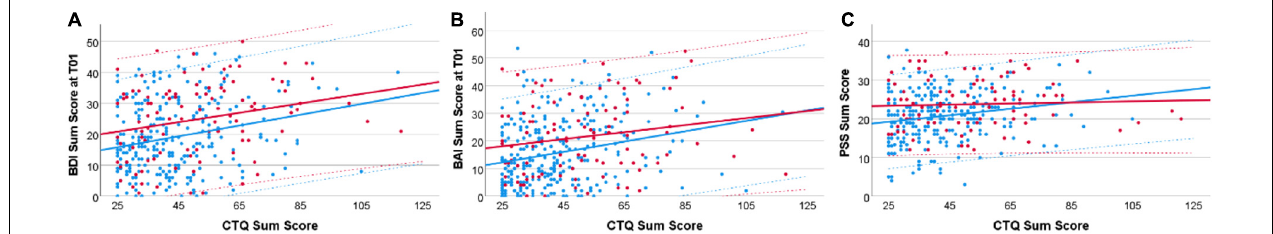
FIGURE 3 | Correlation between CTQ sum score and (A) depressiveness (BDI), (B) anxiety (BAI), and (C) perceived stress (PSS). In males (blue), a significant positive correlation was observed for all three clinical variables. In women (red), a significant positive correlation was observed only for depressiveness. BAI, Beck Anxiety Inventory; BDI, Beck Depression Inventory; CTQ, Childhood Trauma Questionnaire; PSS, Perceived Stress Scale. Dotted lines indicate 95% confidence